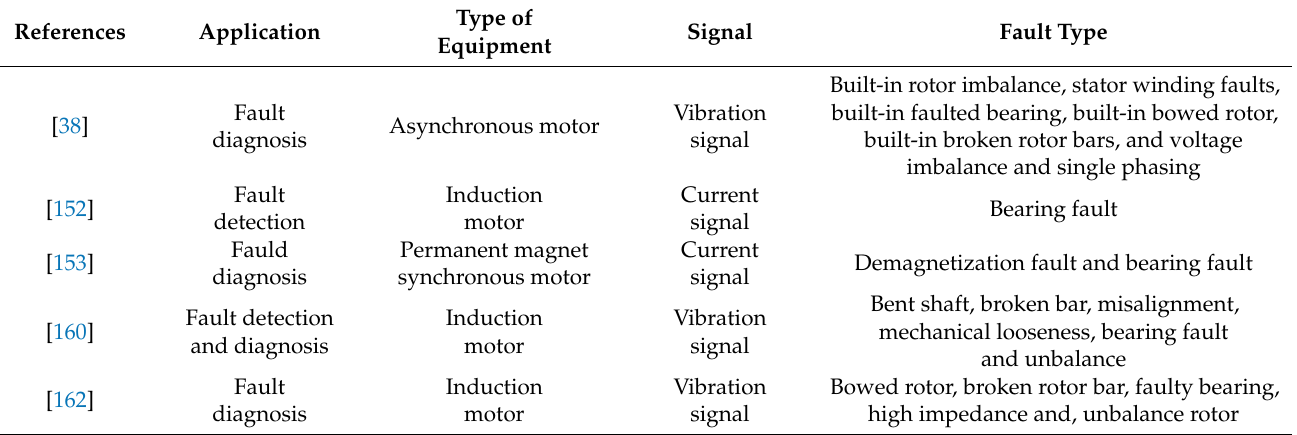
Table 18. Motor condition monitoring using convolutional neural network.